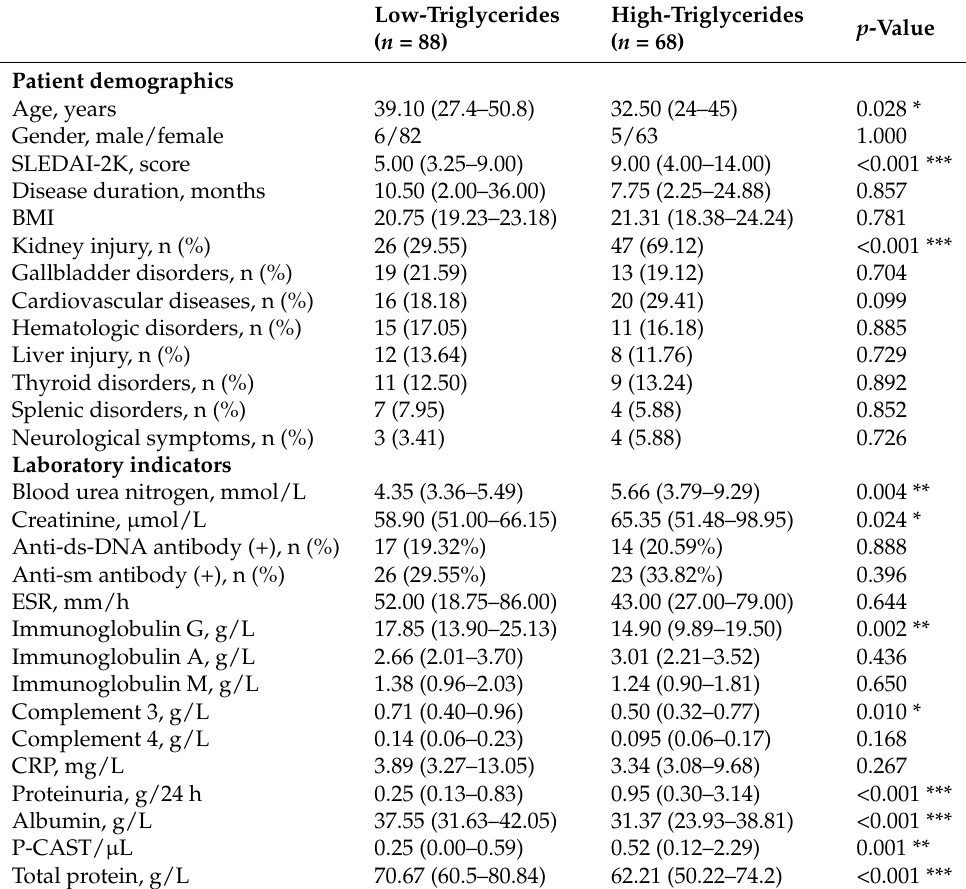
Table 5. Baseline characteristics of SLE patients with low and high triglycerides.